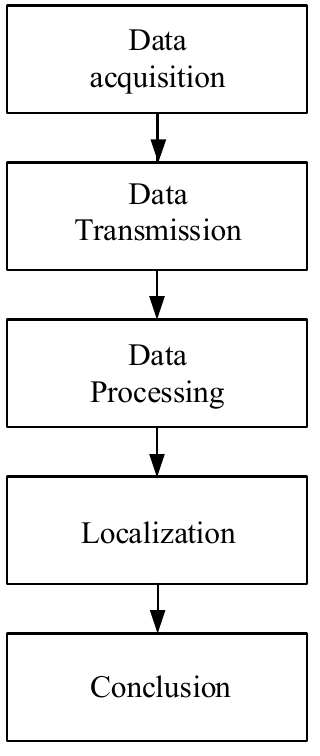
Figure 6. Detection flowchart.